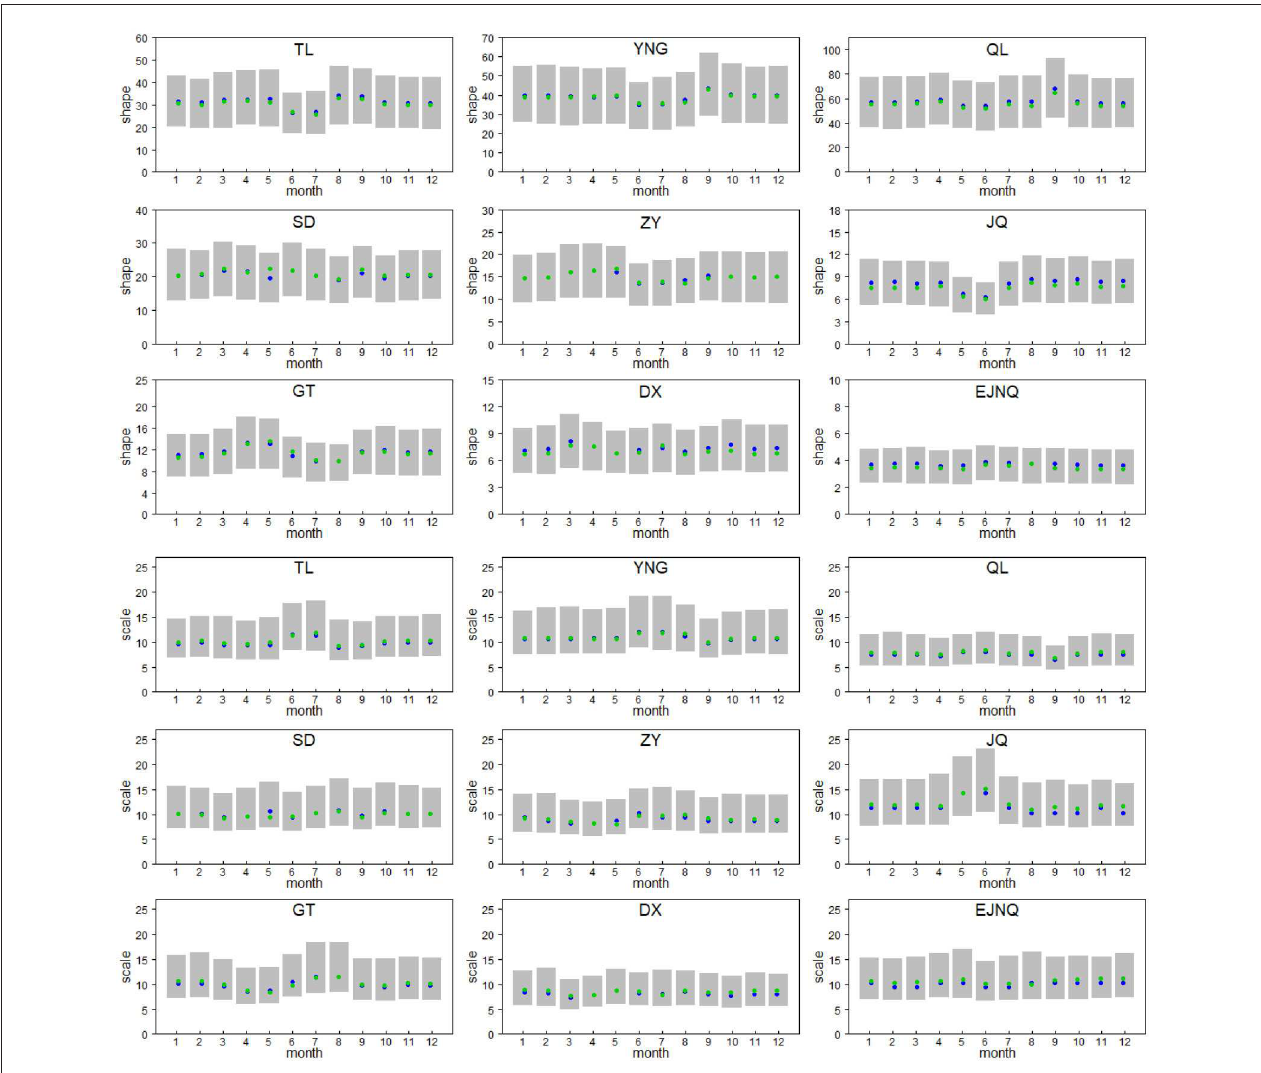
FIGURE 7 | The optimal values and 95% CIs for shape and scale parameters in gamma distribution (the gray shade represents the 95% CIs; the blue and green points represent the optimal parameters from MLE and L moment methods, respectively; the abbreviated names of stations are the same as in Figure 3 ).